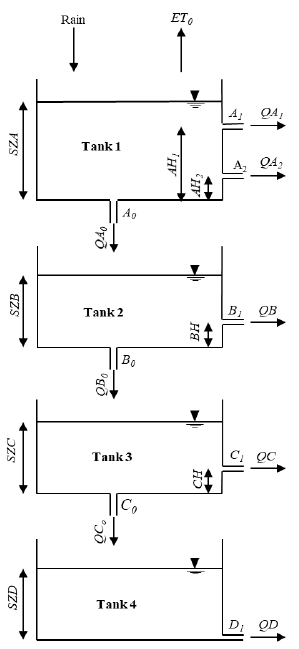
Figure 2. Schematic of tank model